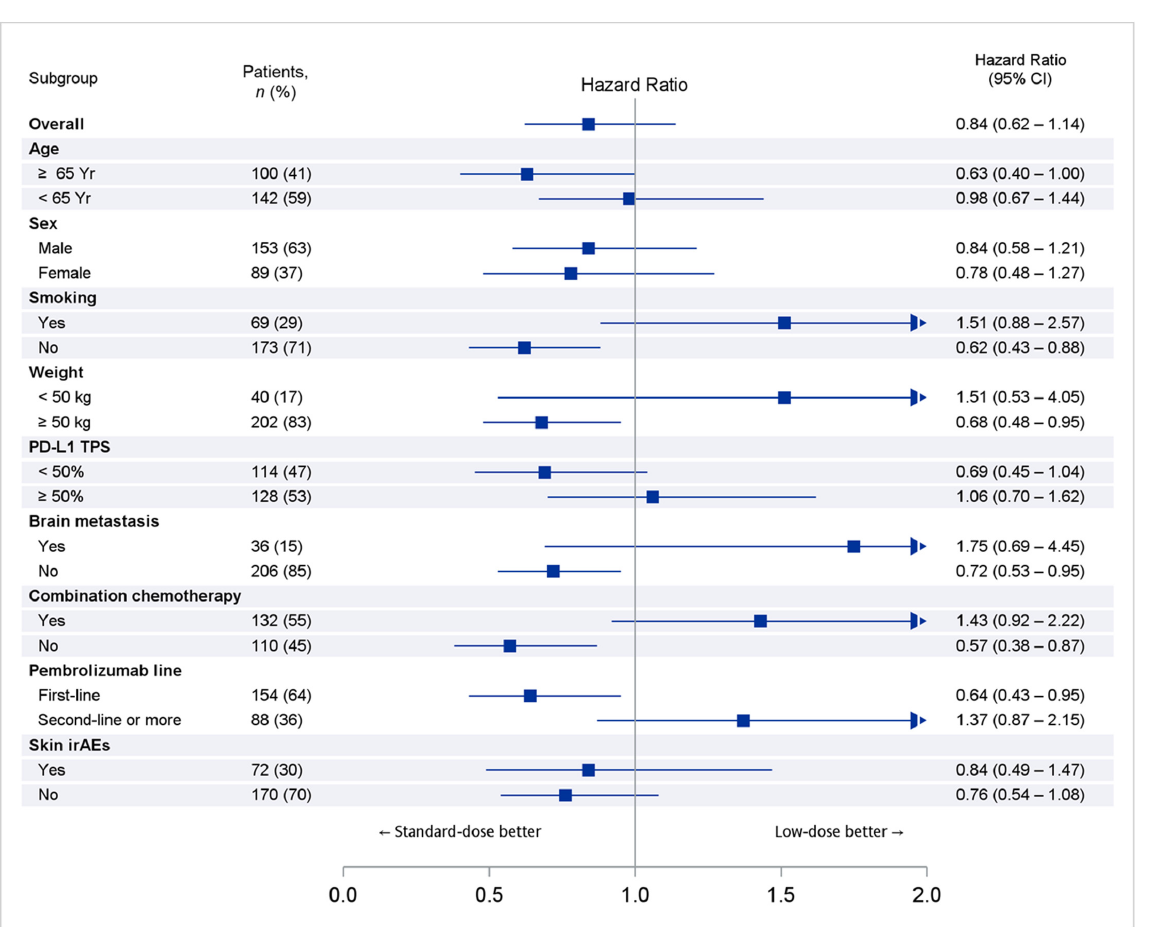
Figure 3. Subgroup analysis of overall survival after IPTW adjustment. Table 2. Sensitivity analyses of overall survival and time to tumor progression between standard-dose and low-dose groups after IPTW